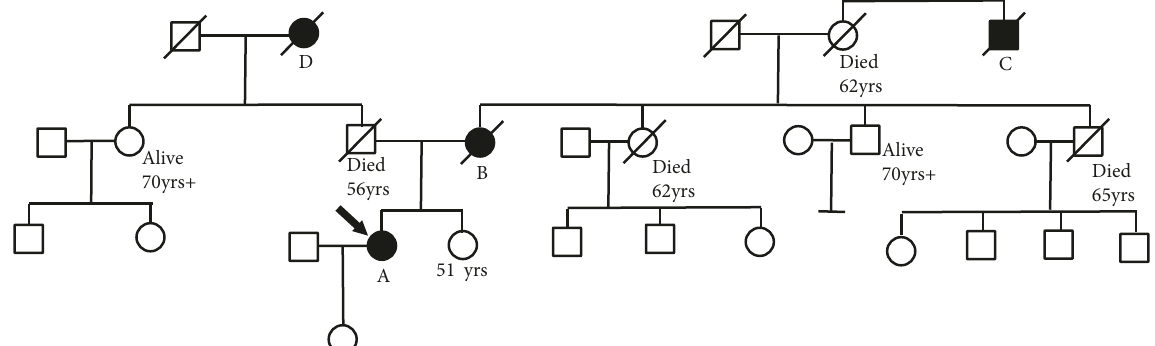
Figure 4: A:family pedigree. Proband for this casereportis family memberA. Othercancer-affectedrelatives: B-D,as described in thearticle.